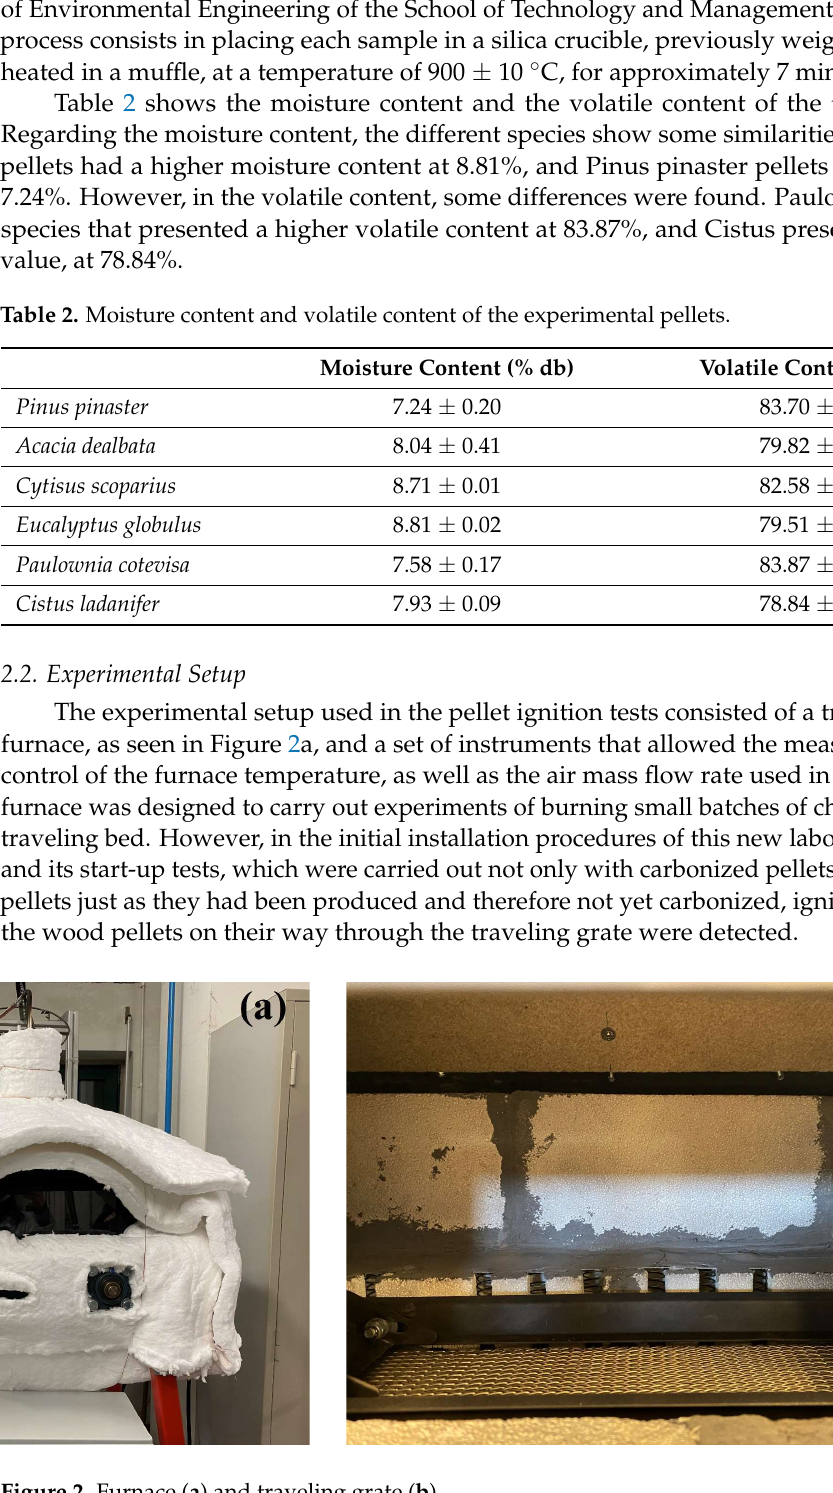
Table 2. Moisture content and volatile content of the experimental